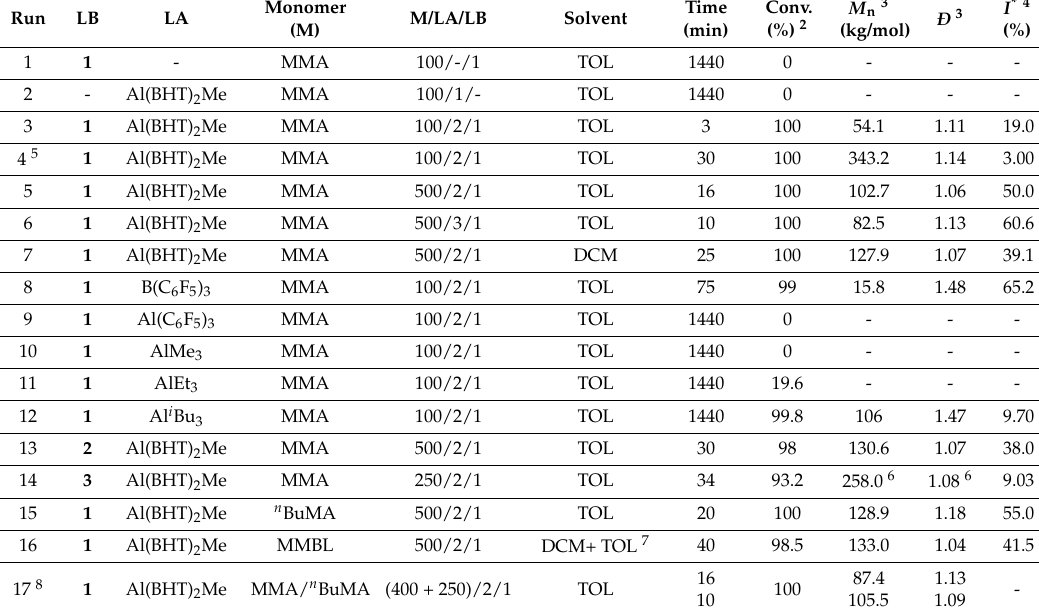
Table 1. Selected results of polymerizations by Al(BHT) 2 Me/NHC LPs 1